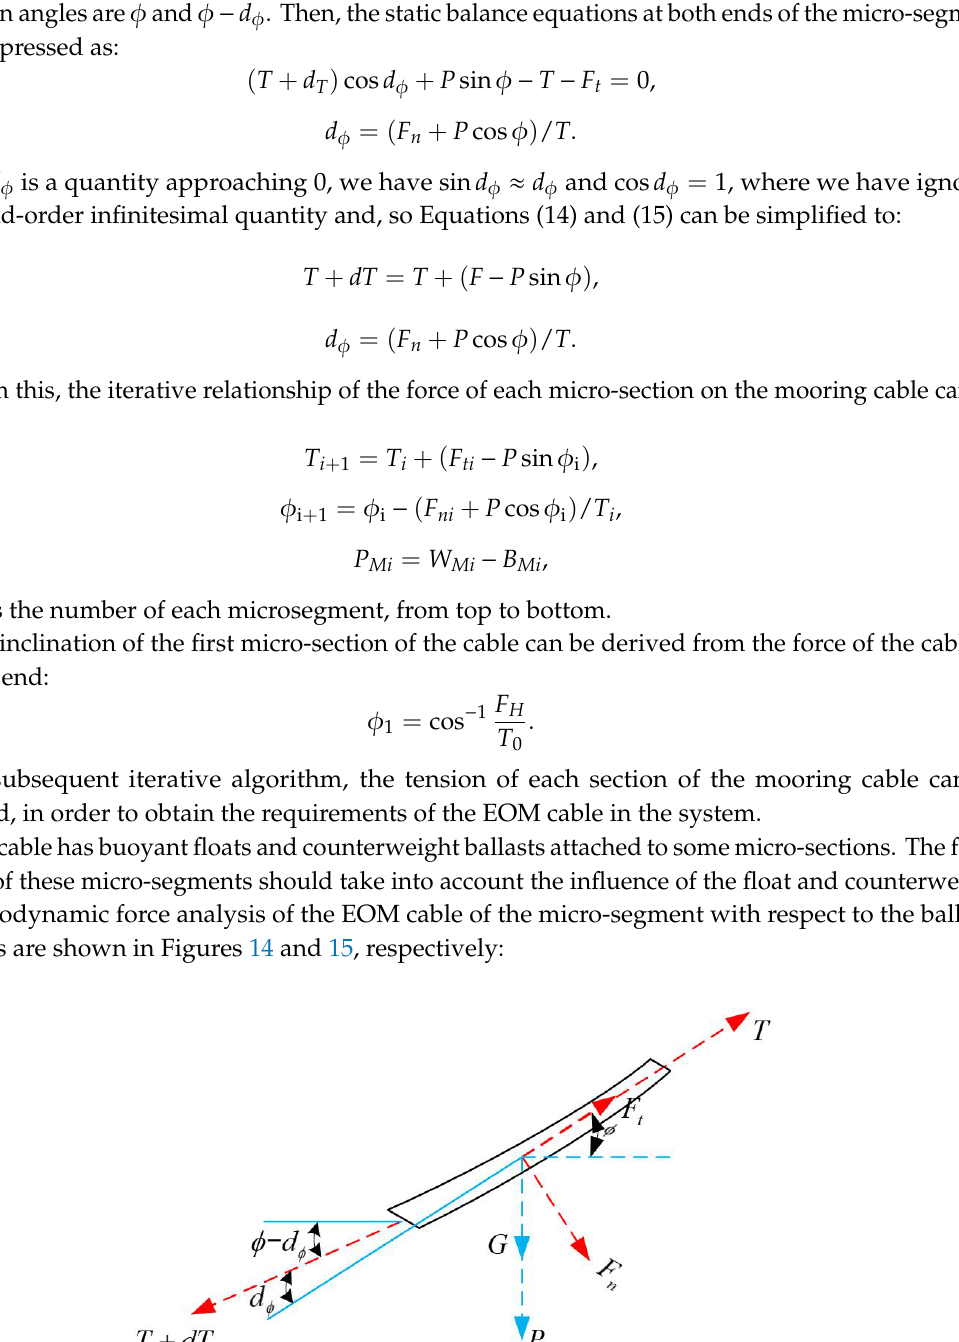
Figure 15. Hydrodynamic force analysis of the EOM cable with attached float.